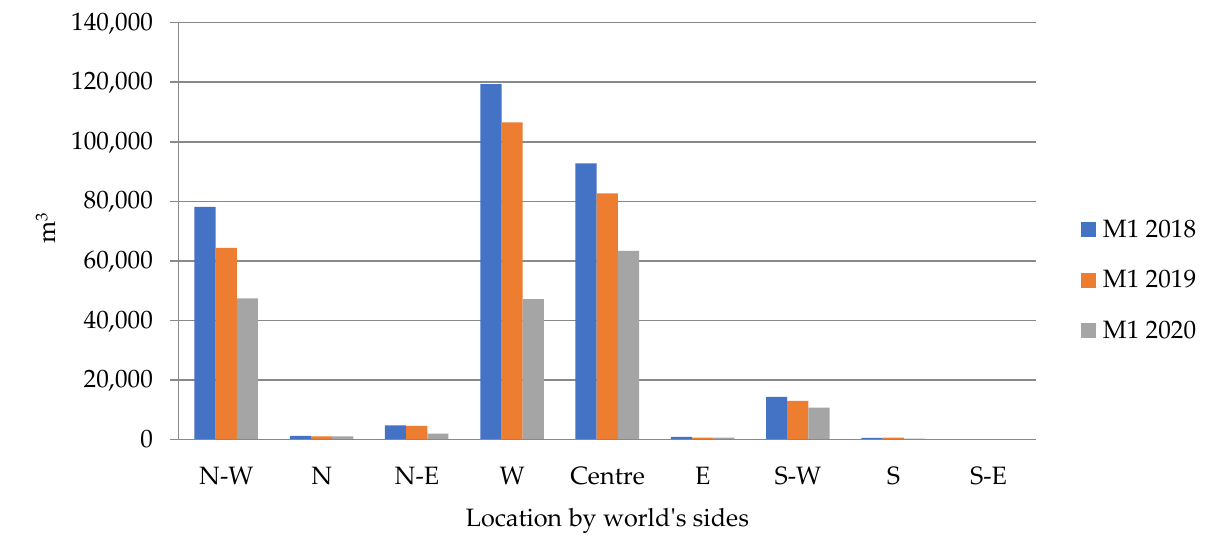
Table 2. The volume and dynamics of wood harvested in forests for chipping (based on: Statistical Yearbook of Forestry 2019 – 2021 [30,31]).